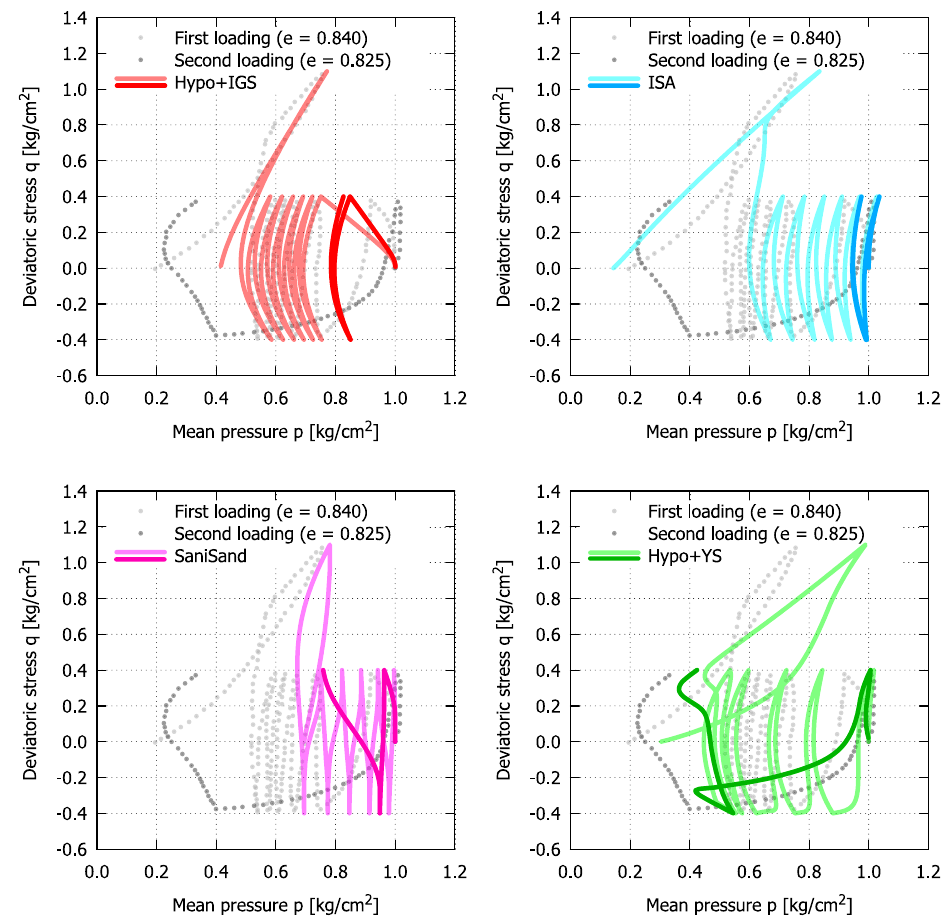
Figure 14. Behaviour of sand subjected to large preshear. Experiment conducted on Fuji River Sand 2 , simulations on KFS for qualitative comparison (light colors represent first loading, dark colors represent second